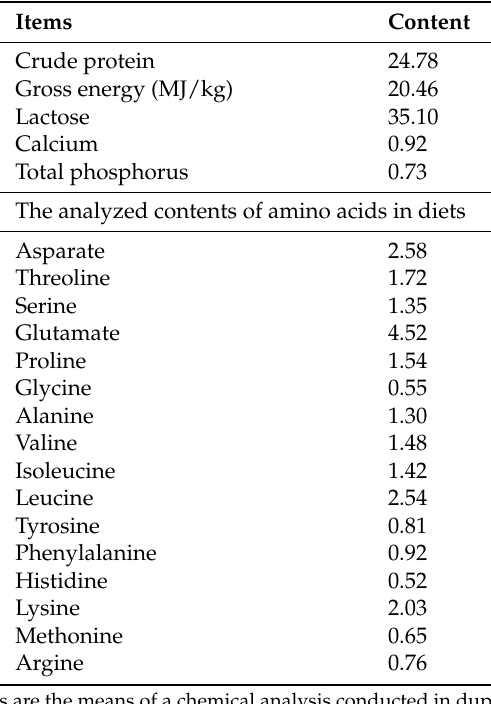
Table 1. Composition and nutrient levels of the experimental diets (%, as-fed basis) 1